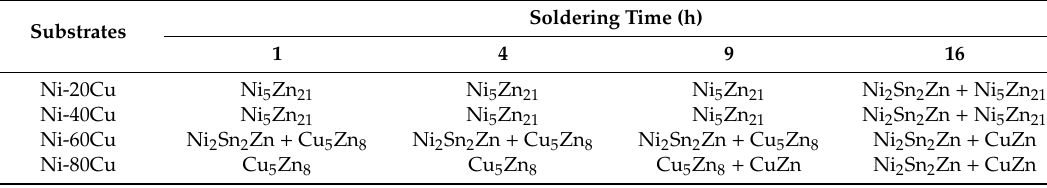
Table 3. Interfacial reaction products of Sn-Zn/Ni-Cu after various durations at 250 °C. Substrates